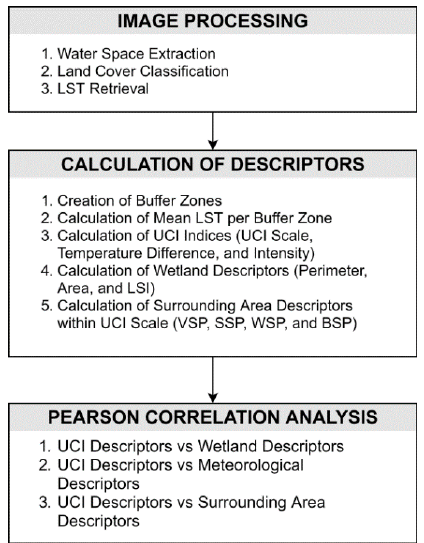
Figure 3. General workflow of the study